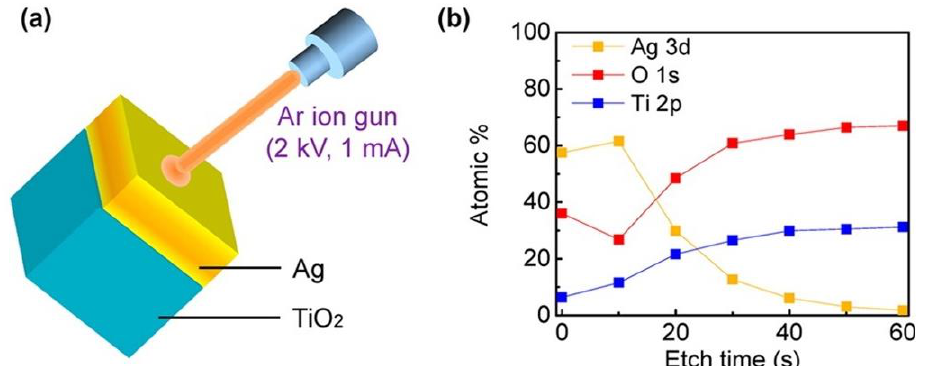
Figure 7. Schematic of XPS depth profile characterization. XPS and UPS are both based on the photoelectric effect, where an incident X-ray or UV photon of energy h ν is absorbed by an atom resulting in the emission of a photoelectron. This photoelectron is of binding energy E b and is ejected with a kinetic energy E k , such that E k = h ν − E b − ϕ , where h is Planck’s constant and ϕ is the work function. In ( a ) the spectra of a 10 nm thin layer of Ag on a TiO 2 film is measured during etching using an Ar ion gun (at 2 kV and 1 mA) 6 times at intervals of 10 s, the result being a map of the depth profile ( b ) of the Ag film on the TiO 2 layer where the atomic compositions are displayed in percentile measures along with their energy level occupancies [154]. Reprinted with permission from Ref [154] Copyright American Chemical Society (2014).